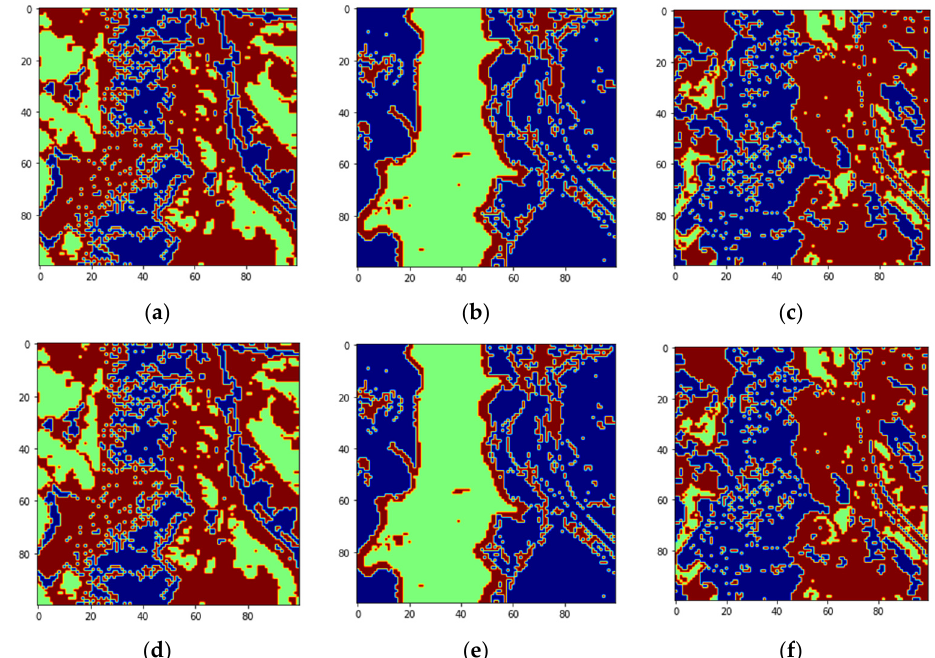
( f ) Figure 15. The confusion matrices for 2 labels Not Belong (NB) and Belong (B) given to the ( a ) trees, ( b ) water, and ( c ) soil pixels of the Jasper HSI in the top row. Bottom row shows the confusion matrices for 3 labels Strong Belong (SB), Weak Belong (WB), and Not Belong (NB) given to the ( d )